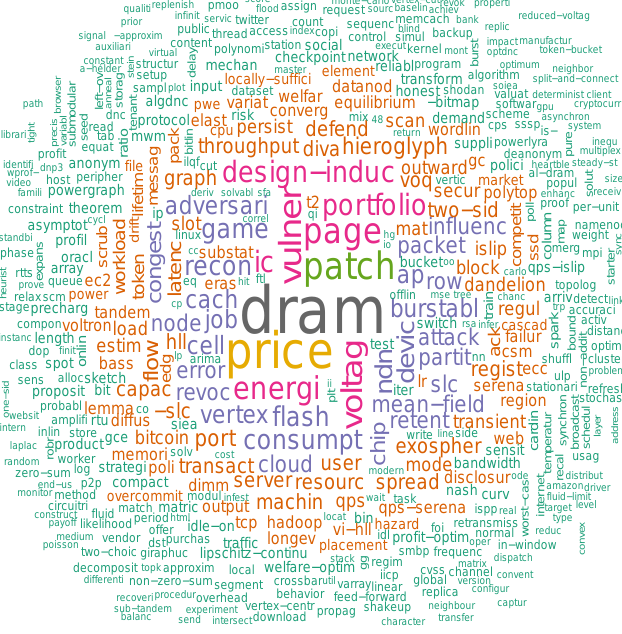
Figure 7. Word cloud of top terms by